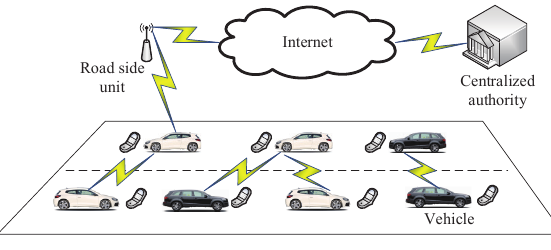
Figure 16. The network model in